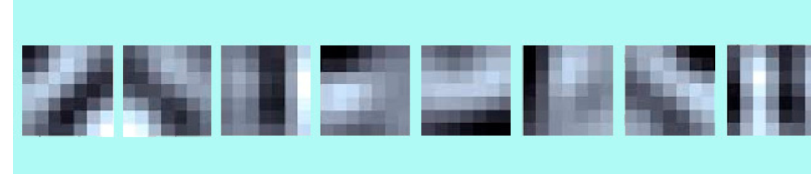
Figure 2. Examples of 7 × 7 BSIF filter banks learned from natural pictures.